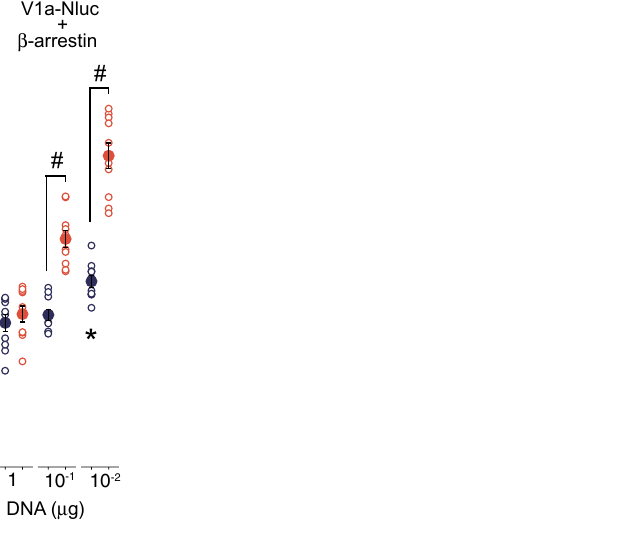
Figure 4. β-arrestin 2 was necessary for increasing the NanoBRET signal in cells expressing V1a-Nluc. Cells growing on a 35 mm dish were transfected with different amounts of the V1a-Nluc plasmid with or without the β-arrestin 2-Venus plasmid (1.5 µg). The NanoBRET signals were measured after treatment with 1 µM AVP or buffer. (n = 10) *indicates that the basal BRET level was increased by V1a-Nluc (0.01 µg) plus β-arrestin 2-Venus (1.5 µg; p < 0.05). # indicates that the NanoBRET was increased following AVP stimulation ( p < 0.05). The statistical computer program R version 4.0.3 (R Core Team, [2020], Vienna, Austria. https:// www.r- proje ct. org) was used to prepare Fig.